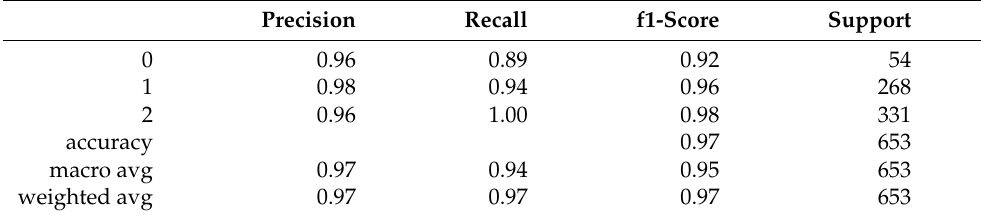
Figure 14. Gradient boosting tree confusion matrix on San Lorenzo test case. Table 13. ANN metrics on San Lorenzo test case.